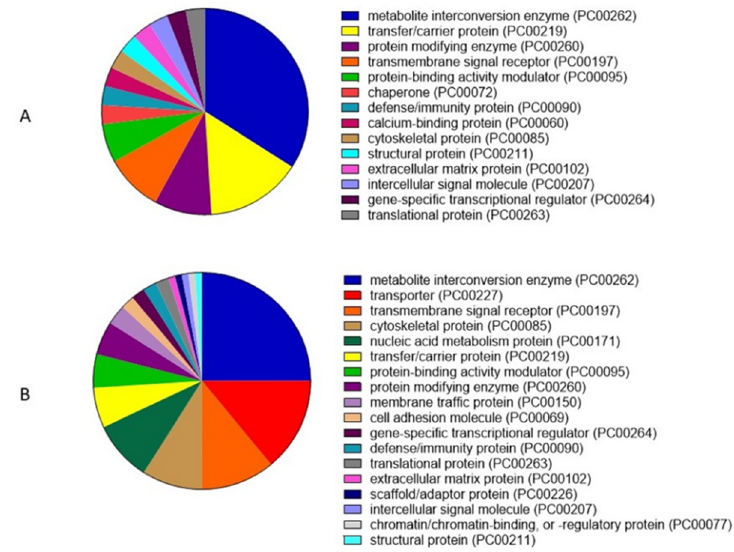
Figure 7. Protein classes in ( A ) sperm intracellular proteins (SIPs) and ( B ) sperm membrane-associated proteins (SMAPs) of the dog ( Canis lupus familiaris ) cauda epididymal spermatozoa. The protein class was analyzed by the PANTHER Classification System (v. 16). Each color represents percentage of protein participation in each protein class.